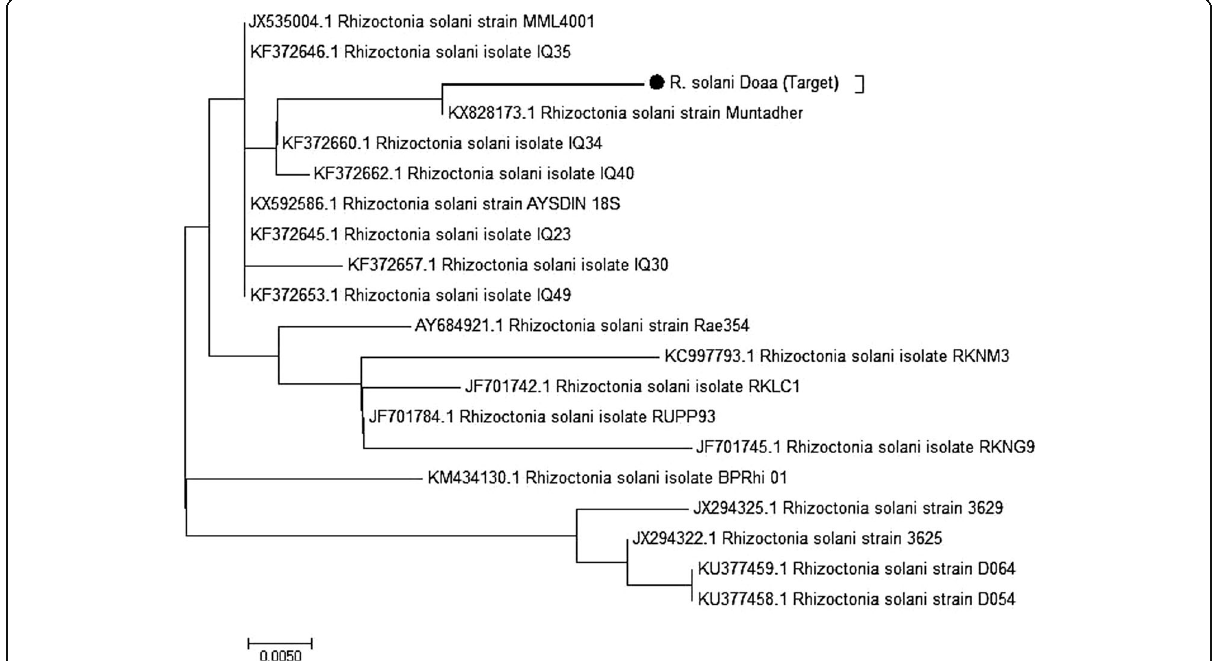
Fig. 4 A phylogenetic tree, generated using the neighbor-joining method showing the genetic relationship among the Iraqi F. solani isolate (indicated by black dot ● ), with those of other R. solani isolates available in GenBank